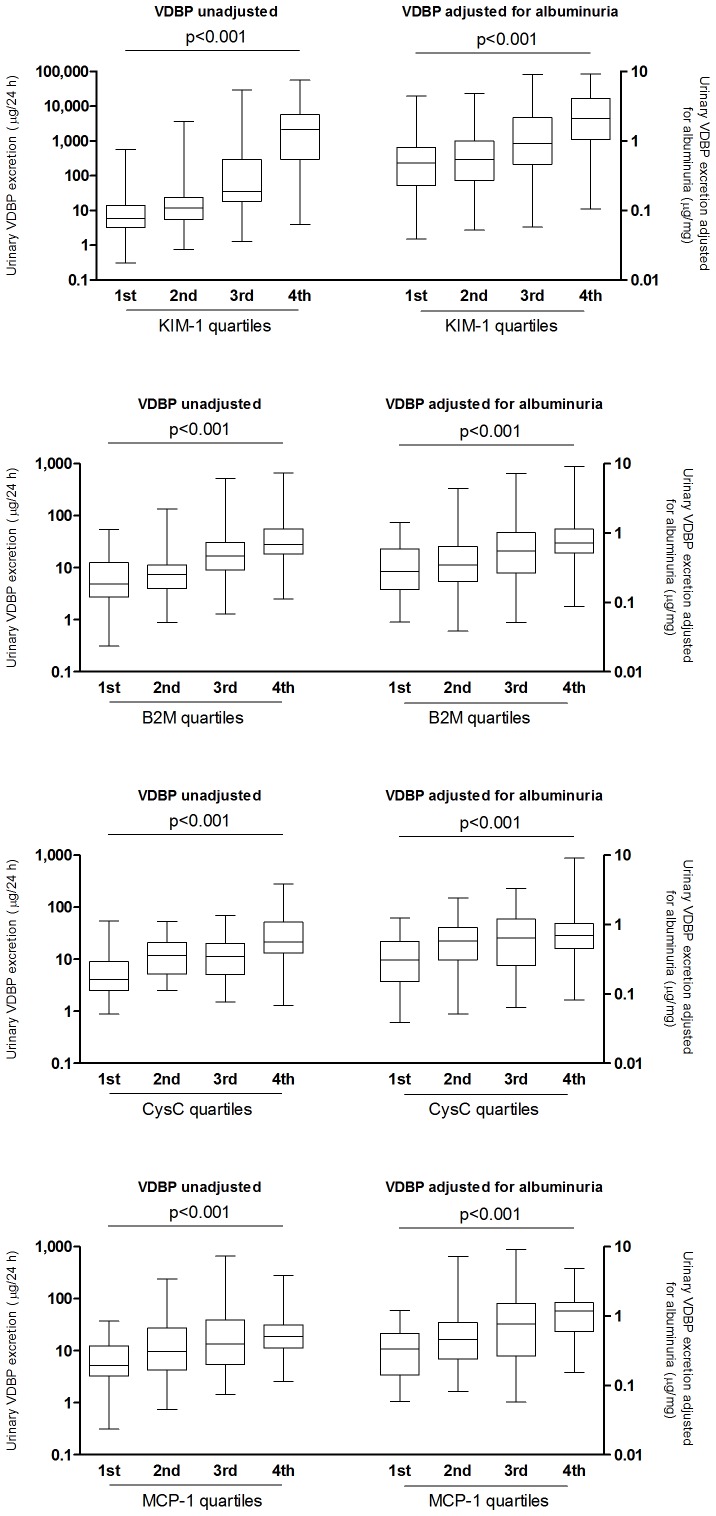
Urinary vitamin D binding protein (uVDBP) and established renal tubular damage markers in patients with renal damage.Box-whisker plots illustrating the relation between uVDBP and established renal tubular damage markers kidney injury molecule-1 (KIM-1) (A), beta-2-microglobulin (B2M) (B), Cystatin C (CysC) (C) and monocyte chemoattractant protein-1 (MCP-1) (D) in normo- and microalbuminuric subjects (both n = 100). The uVDBP is presented per quartile of the established renal damage marker studied. In all panels (A-D), the left four box whisker plots represent the unadjusted VDBP excretion, and the right four box whisker plots represent the uVDBP adjusted for albuminuria. All biomarkers are positively associated with uVDBP, also when VDBP was adjusted for albuminuria (p<0.001, Kruskal Wallis).